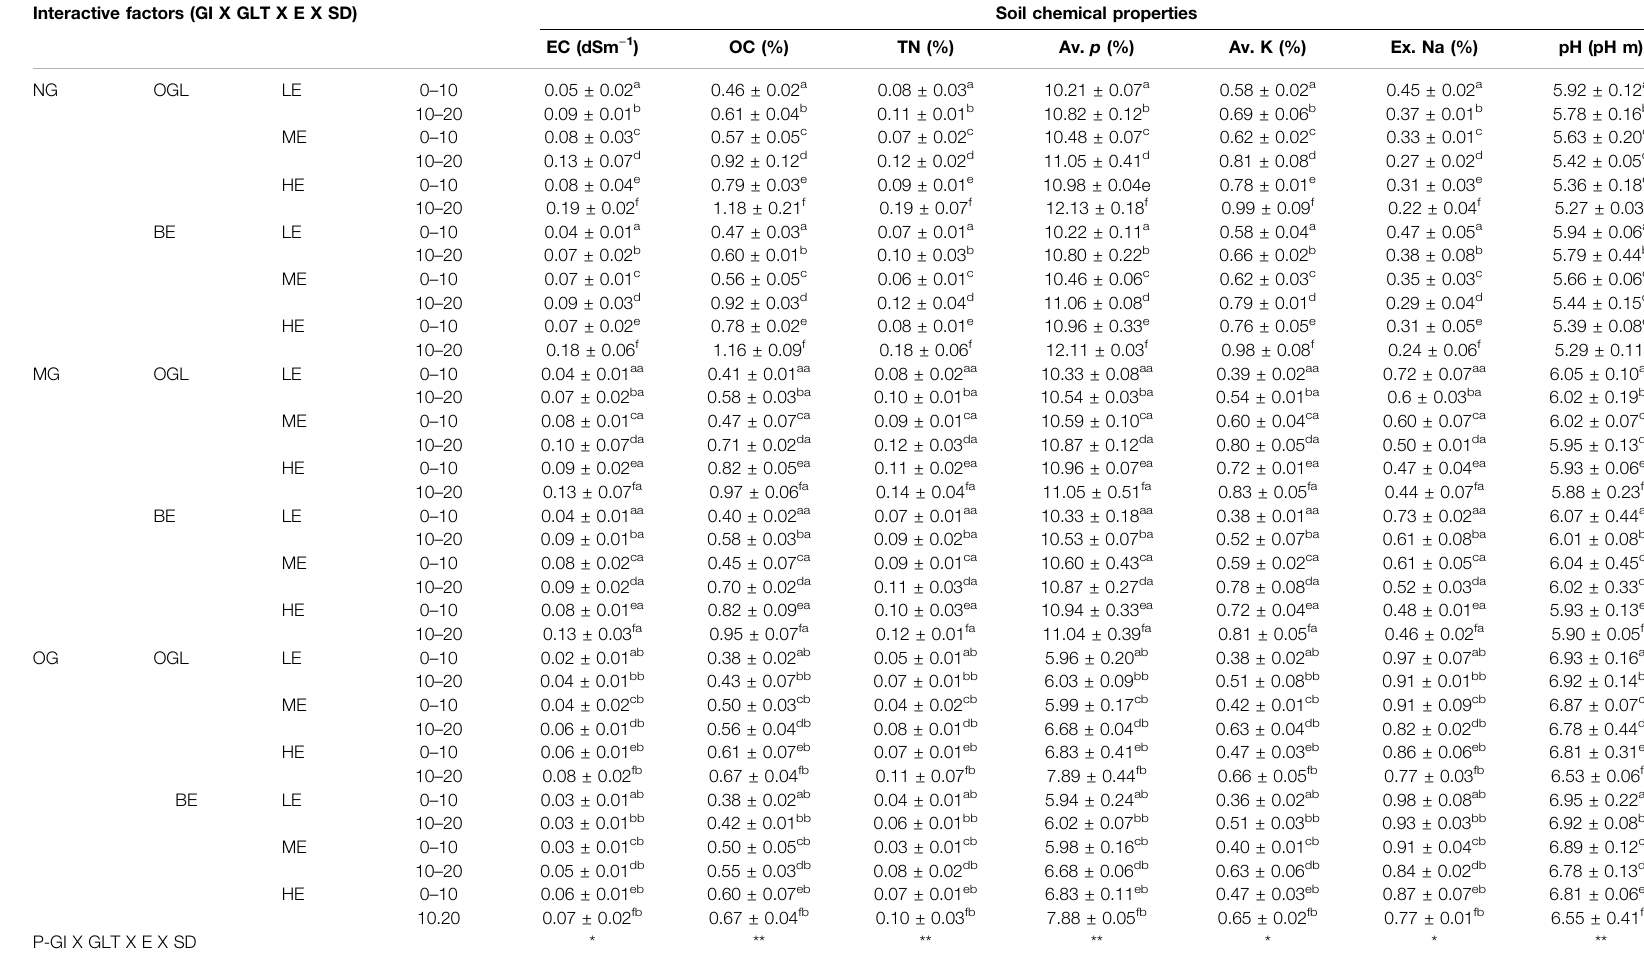
TABLE 5 | Mean ( ± SE) value of soil chemical properties distribution under the interaction effects of grazing intensity with grazing land type, elevation and soil depths. Interactive factors (GI X GLT X E X